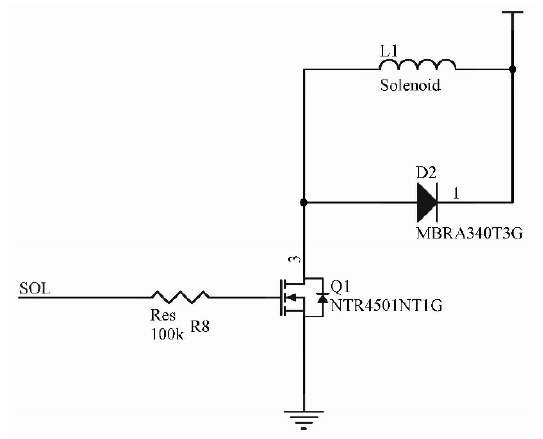
Figure 6. Schematic of the solenoid driver circuit.